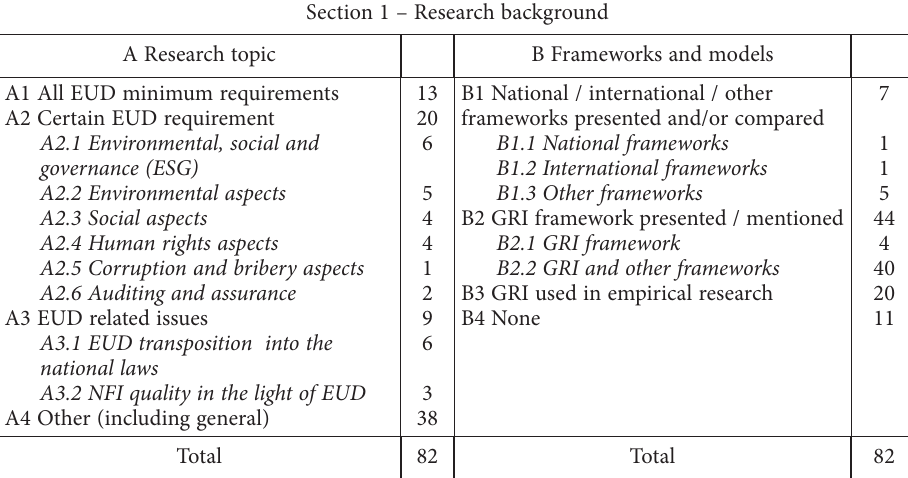
Table 2. Analytical framework for analysing EUD